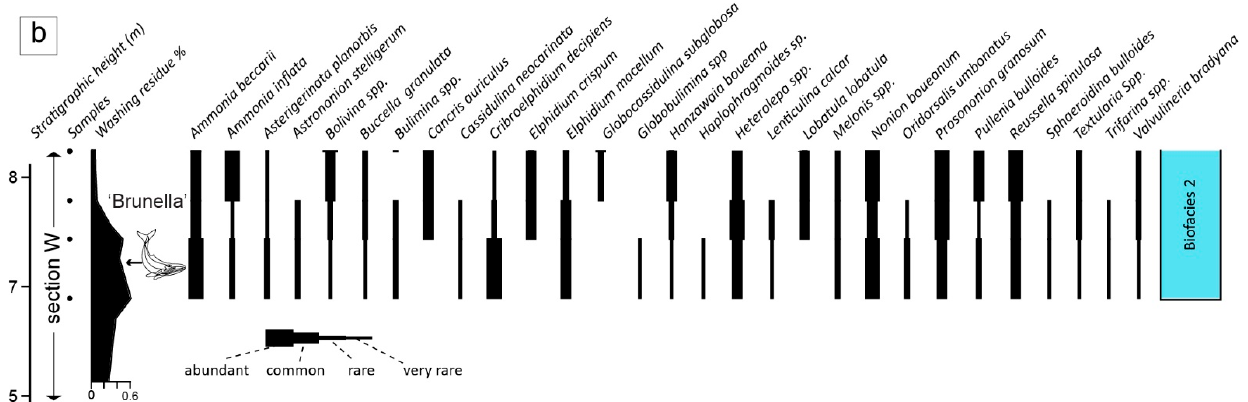
Figure 12. Spindle diagrams illustrating the stratigraphic distribution and estimated abundance of the most significant benthic Foraminifera species in ( a ) the investigated stratigraphy (sections G and H) and ( b ) the deposits embedding Brunella (section W).